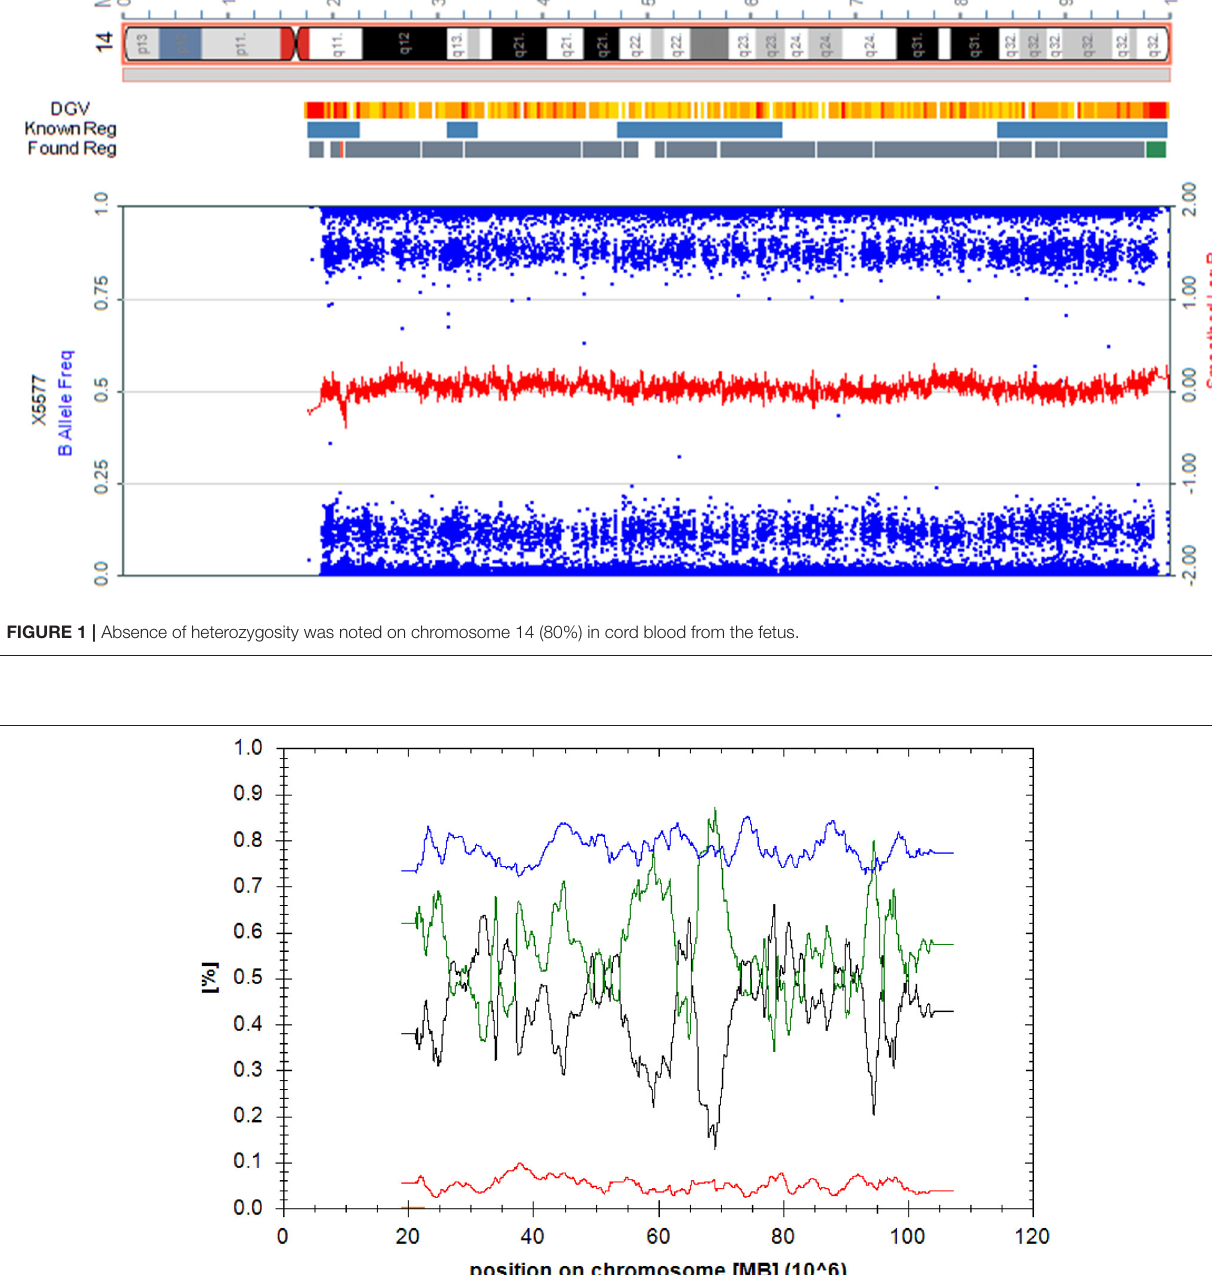
Frontiers in Pediatrics |